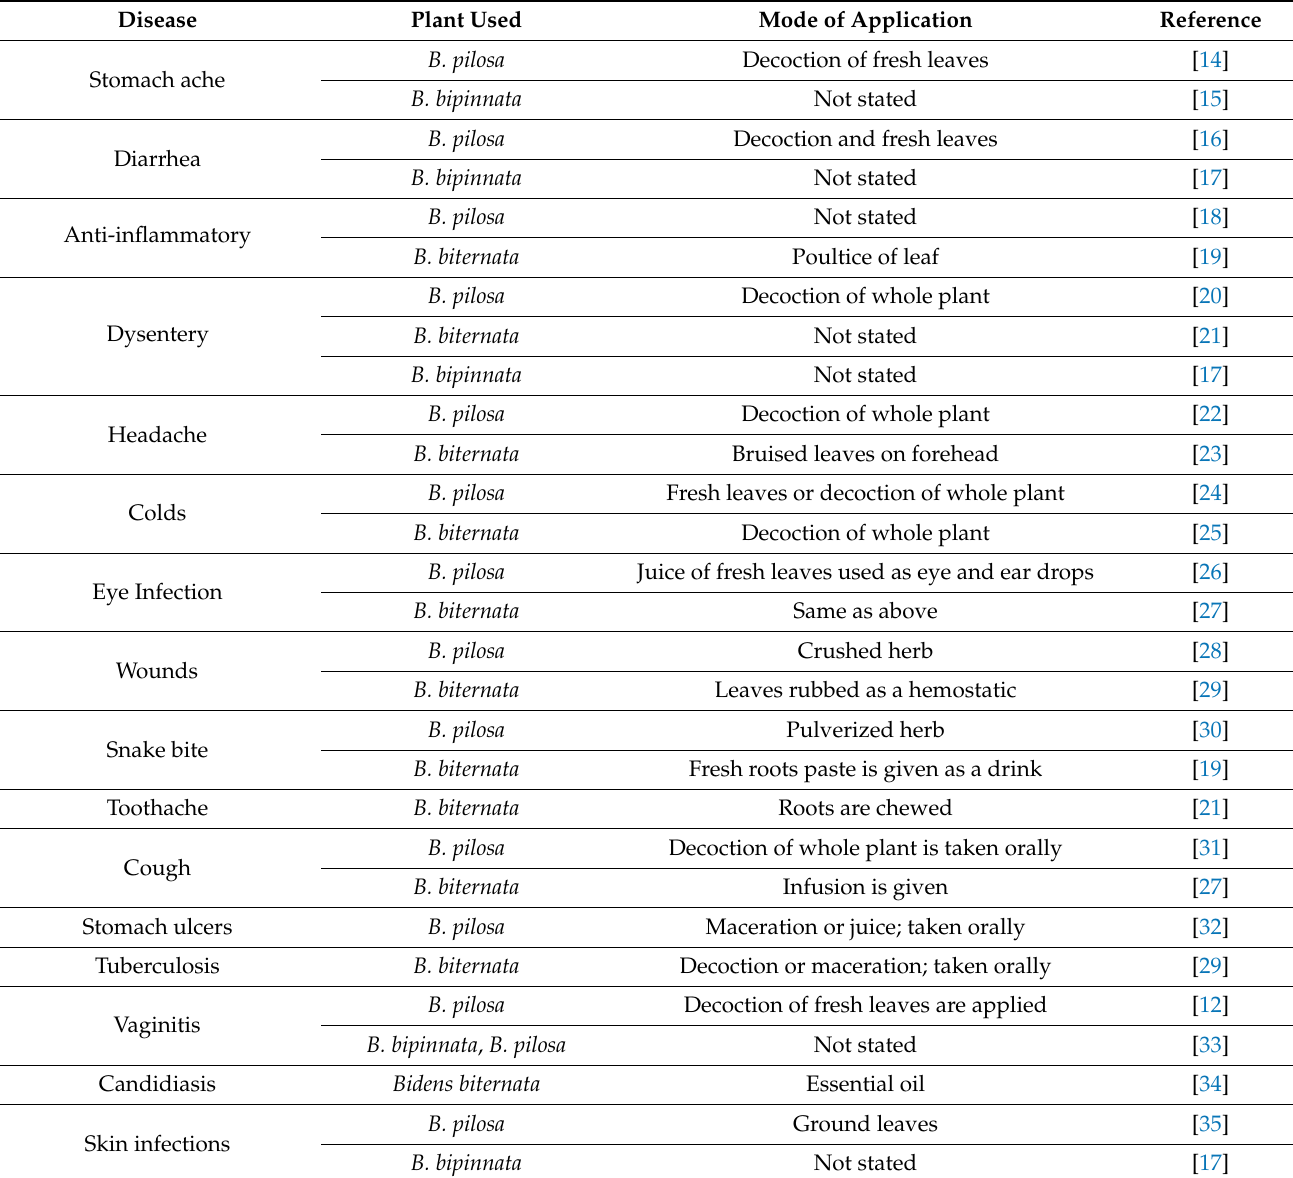
Table 2. Ethnomedicinal uses of Gui Zhen Cao